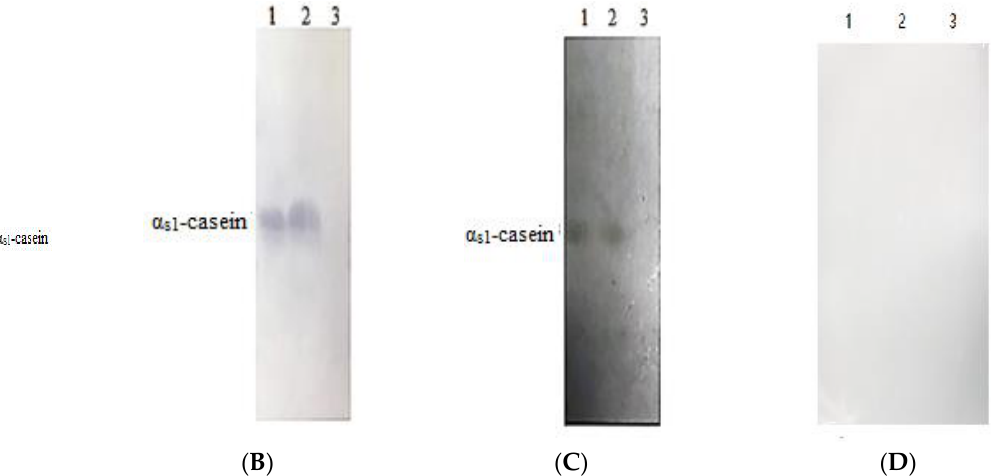
Figure 2. SDS-PAGE electrophoresis profiles ( A ) and immunoblotting of mAb against α s1 -casein epitope ( B ), α s1 -casein protein ( C ), or negative serum ( D ). M represents protein markers; Lanes 1, 2, and 3 represent α s1 -casein, skim milk, and soy protein, respectively.